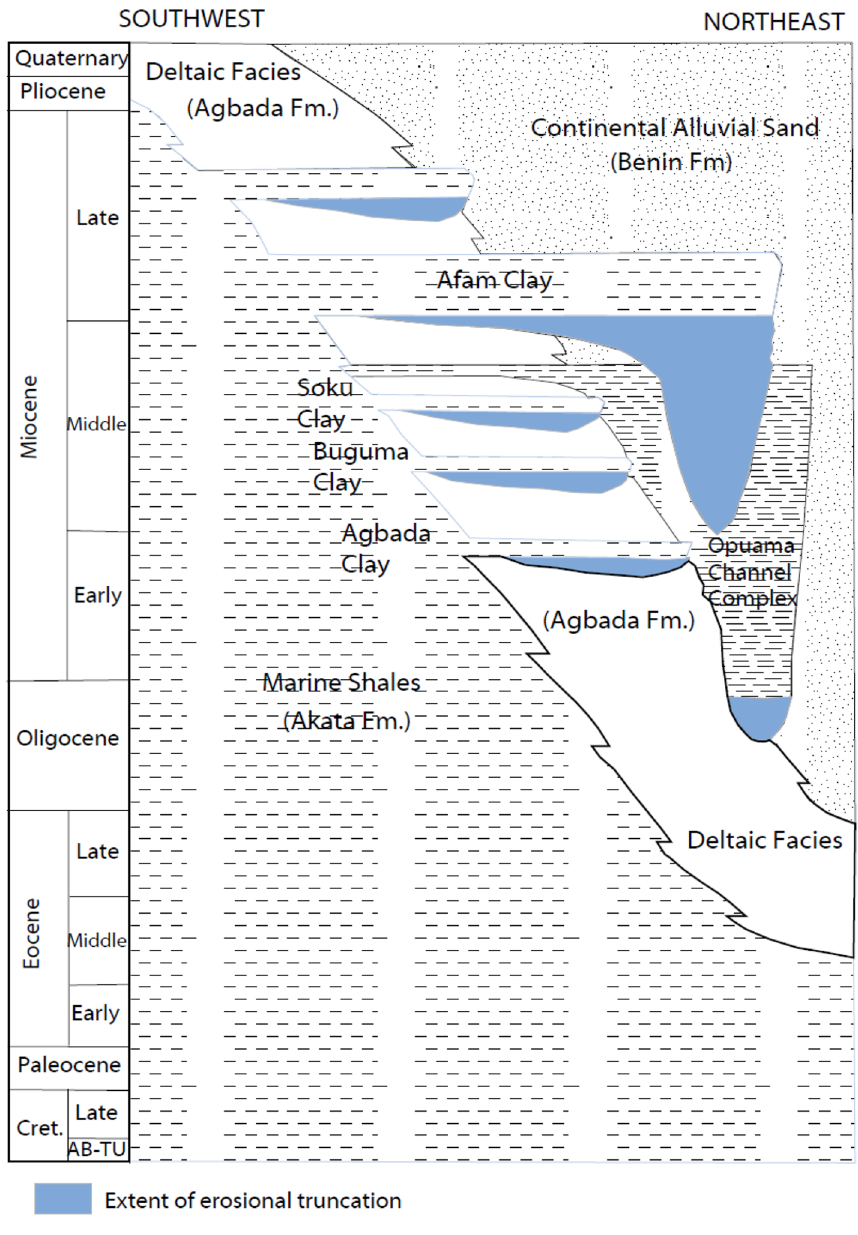
Fig. 4 Stratigraphic column showing the three formations of the Niger Delta. (Shannon and Naylor 1989; Doust and Omatsola